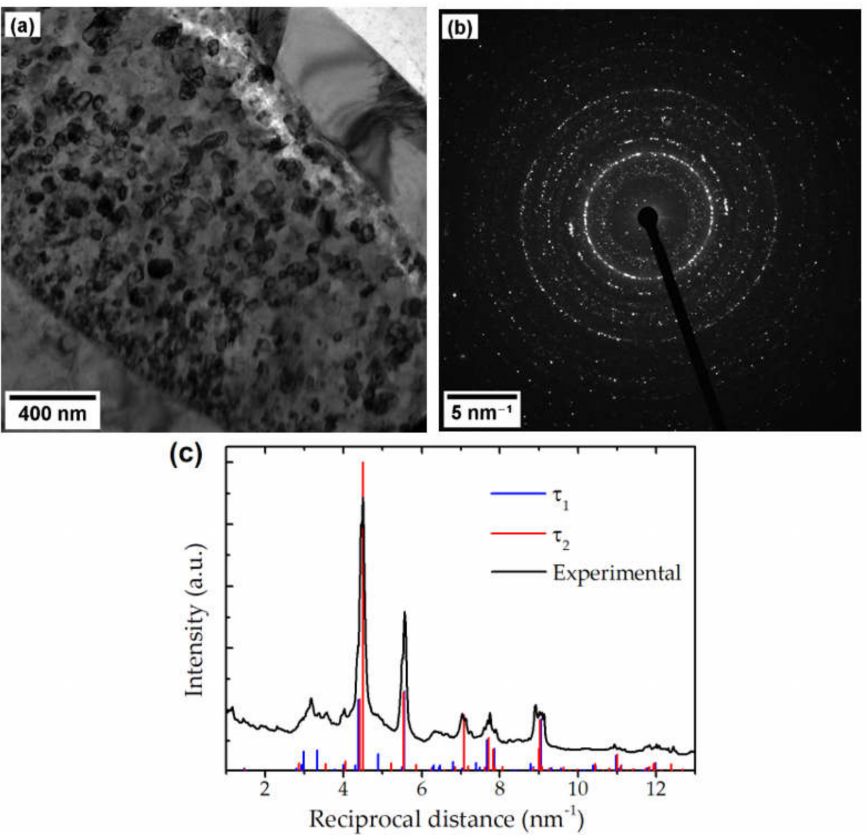
Figure 9. ( a ) BF TEM micrograph of the diffusion layer. ( b ) Corresponding powder diffraction rings of the diffusion layer. ( c ) Radially integrated experimental profile ( b ) with the theoretical positions of the τ 1 and τ 2 lines. The height of the line corresponds to its relative